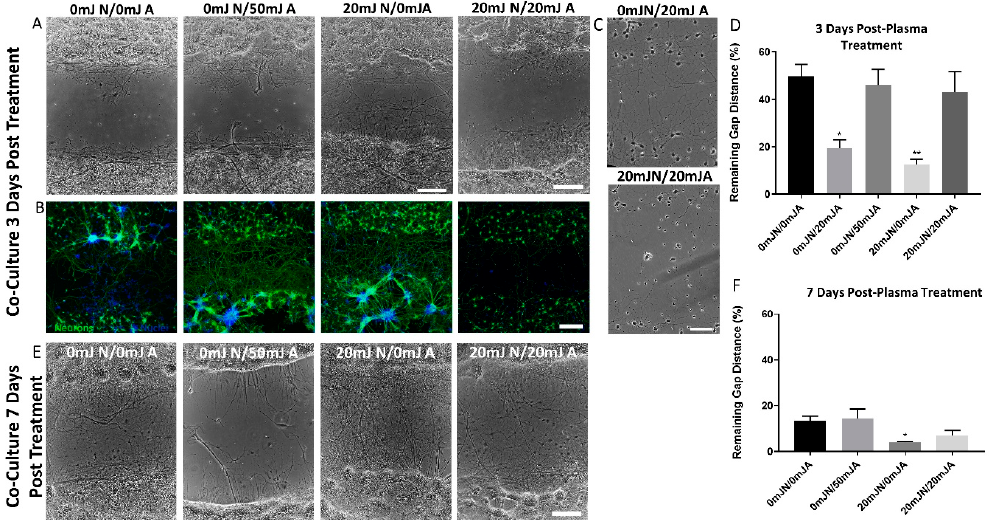
Figure 4. Astrocyte stimulation with plasma increased neurite outgrowth under